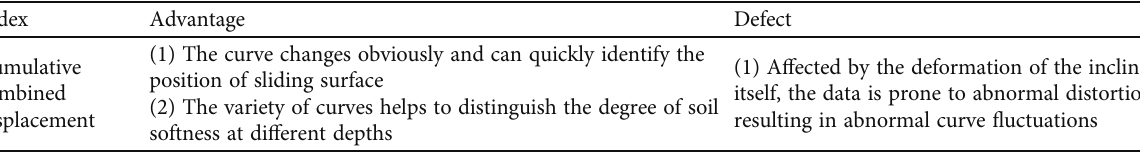
Table 1: Applicability of each